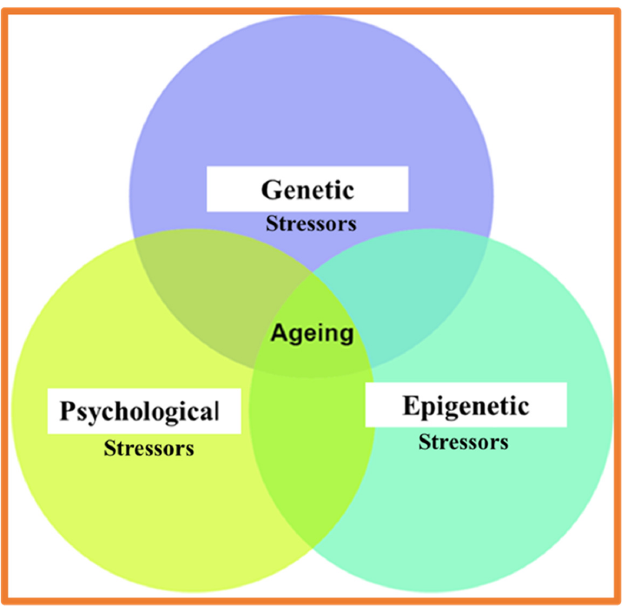
Figure 2. Major determinant of biological